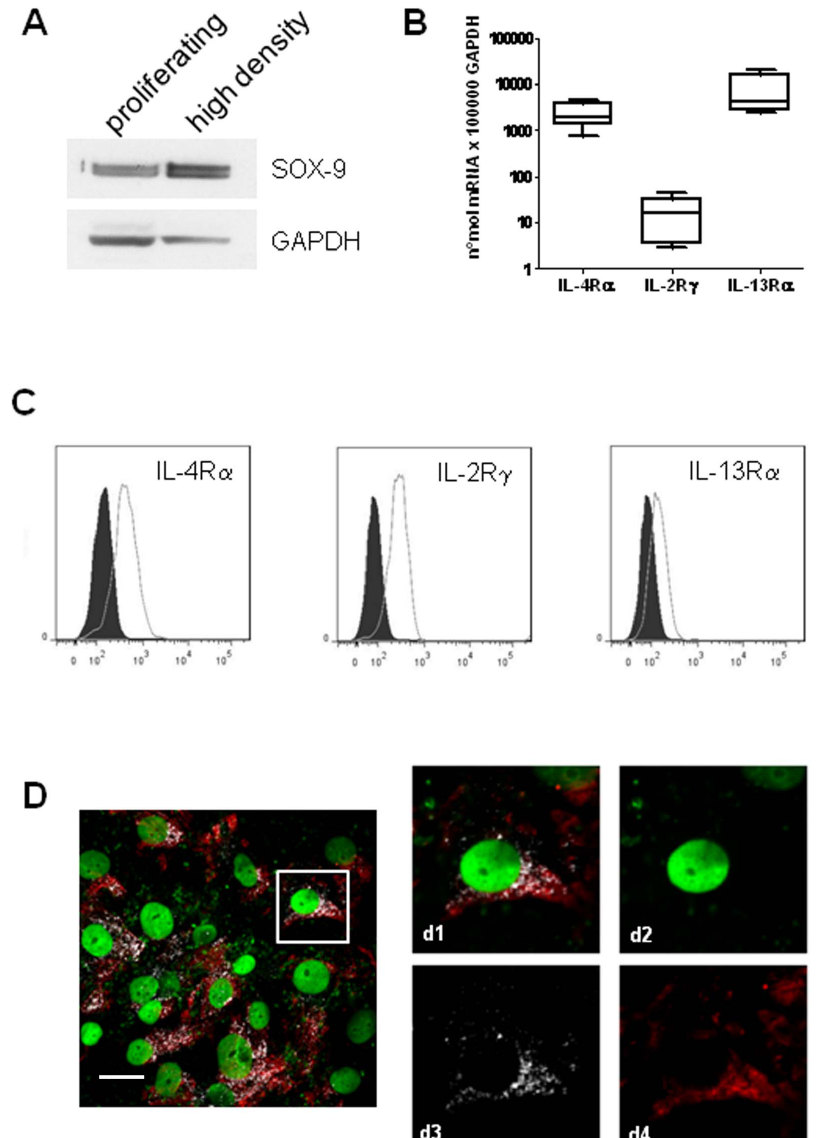
Figure 4. Assessment of the maintenance of a differentiated phenotype and evaluation of IL-4R subunits repertoire by high density cultures of primary chondrocytes. A: SOX-9 protein expression in high density cultures compared to proliferating chondrocytes by western blot analysis. The housekeeping protein GAPDH is used as a loading control. A representative example out of the four examined. B: Cumulative evaluation of IL-4 receptor subunit gene expression in high-density chondrocytes in 5 different patients. Values represent the number of molecules per 100,000 GAPDH as assessed by real time PCR. Boxes indicate the 25% and 75% percentiles, whiskers indicate the minimum to maximum values, and bars indicate the median. C: flow cytometric analysis of the level of expression of each IL-4R subunit in high density culture OA chondrocytes. Dark pattern: isotype control; white pattern: Dy Light 647 signal referring to IL-4R a (left), IL-2R c (middle) and IL-13R a (right). Each curve refers to 5,000 cells. D representative example of IL-4R a and IL-2R c colocalization (IL-4 Receptor type I) in high-density cultures of OA chondrocytes (bar =25 m m). On the right, higher magnifications showing IL-4R staining (Dy Light 647, rendered in red in d4), IL-2R c (Alexa 555, rendered in white in d3), nuclear counterstaining (sybr green, rendered in green in d2) and merged signals